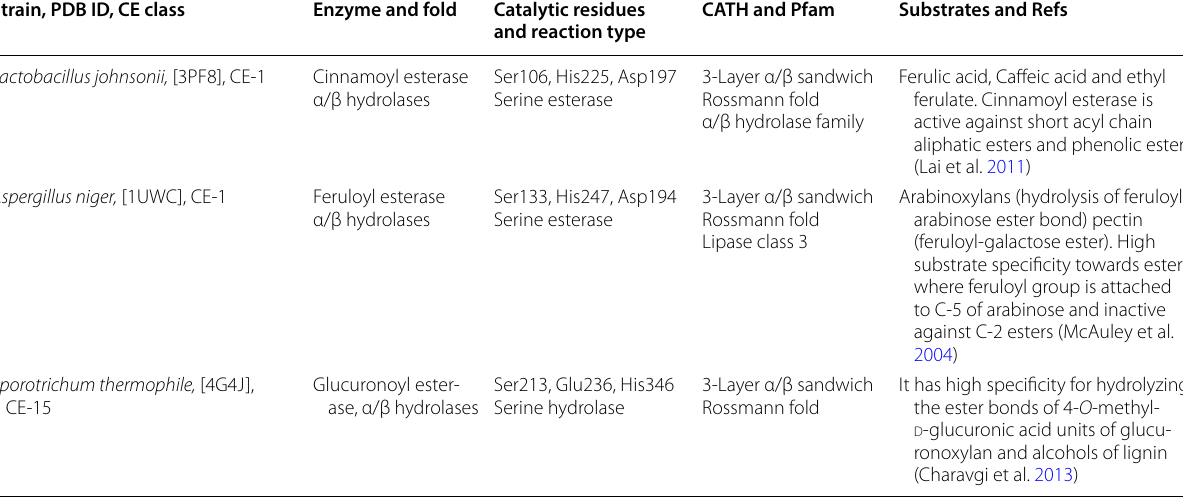
Table 4 List of the structural and functional properties of lignin–carbohydrate complex deacetylating esterases belonging to carbohydrate esterases CE1, CE15 classes Strain, PDB ID, CE